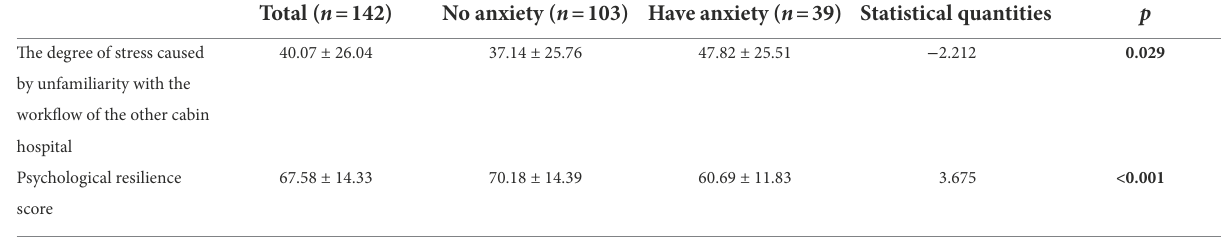
TABLE 9C Analysis of influencing factors of GAD-7.